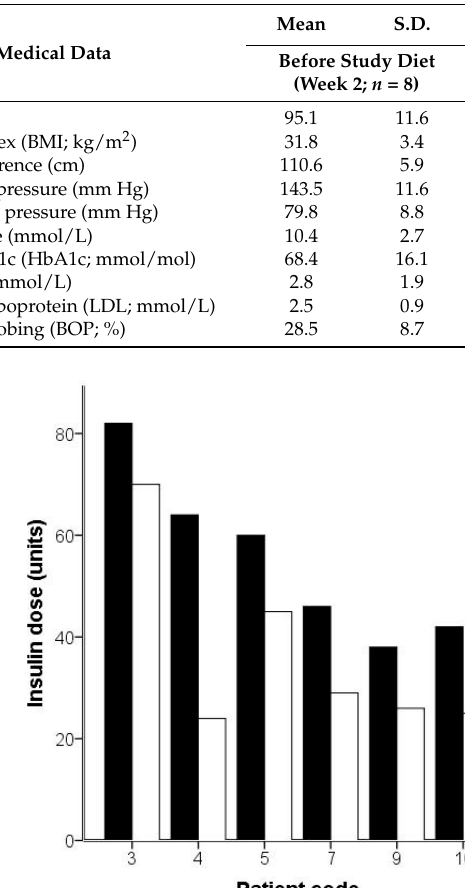
Table 2. Mean levels and standard deviations (S.D.) of medical values in individuals with type 2 diabetes (T2D) at 2 weeks (before intake of study diet), and after two weeks with the study diet.